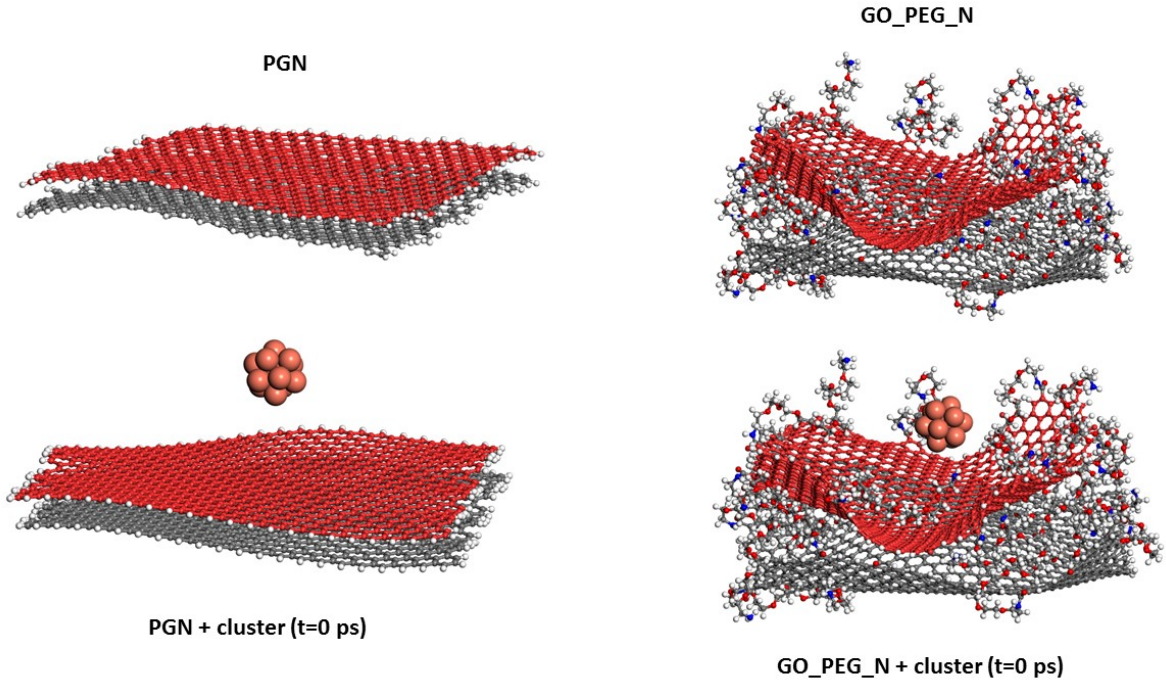
Figure 2. Models of PGN and GO_PEG_N. The starting structures used in the simulations before Cu cluster adsorption on both surfaces are shown in the lower part of the figure. Each basal graphene plane in the nanoplatelets is displayed in a different color for a clearer view.